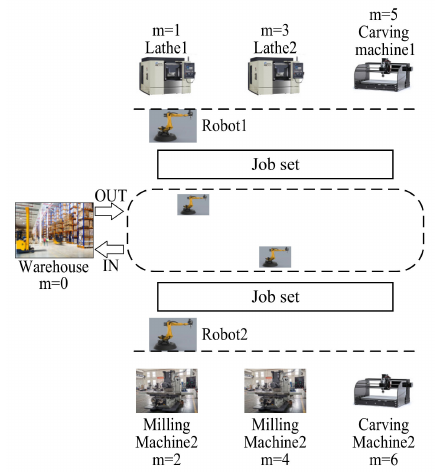
Figure 8. The layout of the simulated environment. Table 2. The processing equipment